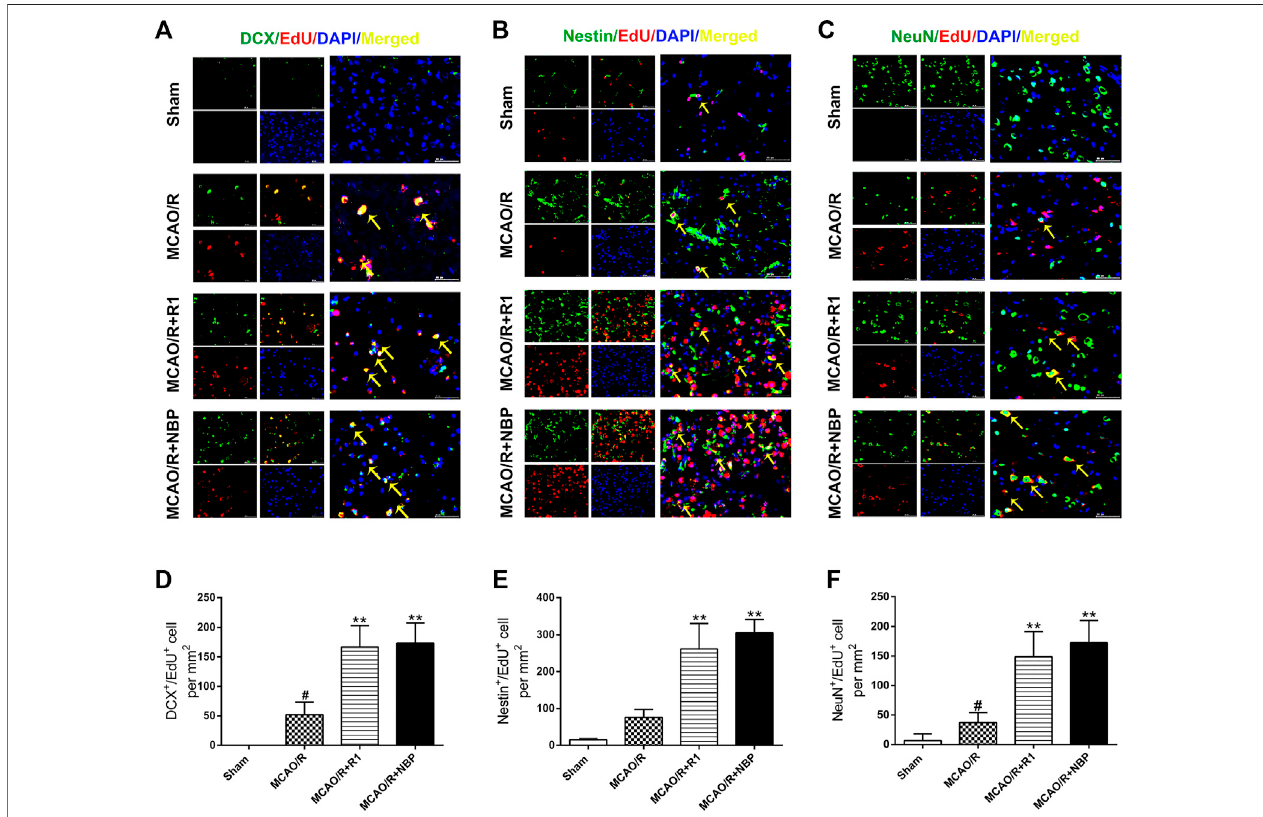
FIGURE 4 | R1 enhances neural reconstruction by stimulating neurogenesis after ischemic stroke. Representative images of the infarction area costained with antibodies against (A) DCX (green, marker of migrating and immature neurons) and EdU (red, marker of proliferating cells) on day 7 after R1 treatment, yellow arrows indicate migrating neuroblasts(EdU + /DCX + cells) (B) Nestin(green,markerofproliferatingNPCs)andEdU(red)onday7afterR1treatment,yellowarrowsindicateproliferatingNPCs(EdU + /Nestin + cells) (C) NeuN(green,markerofmatureneurons)andEdU(red)onday28afterR1treatment,yellowarrowsindicatenewlyformedmatureneurons(EdU + /NeuN + cells).DAPI (blue)indicatesthenucleus,Scalebar (cid:1) 50 μ m (D-F) Quantitativeanalysisof (A-C) inthestriatumregionrespectivelyafterR1treatment. n (cid:1) 3brainspergroup.Dataareexpressed as the mean ± SD and were analyzed by ANOVA. # p < 0.05, ## p < 0.01 vs. Sham group; * p < 0.05, ** p < 0.01 vs. MCAO/R